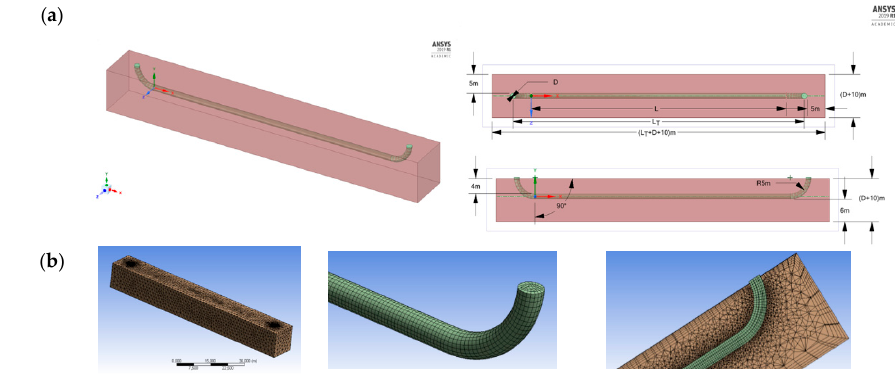
Figure 2. Geometry and mesh of the model.